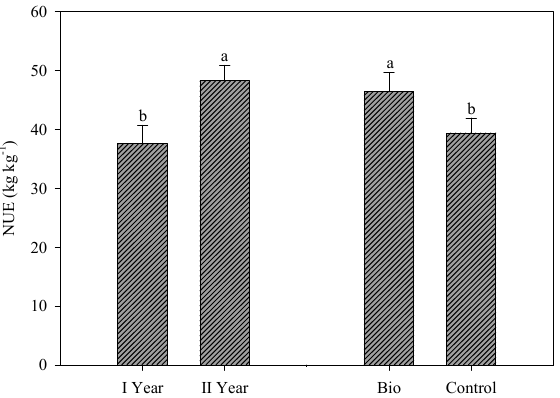
Figure 6. Nitrogen use efficiency (NUE) of barley as affected by growing season (2018–2019 = I Year; 2019–2020 = II Year), biostimulant (treated with biostimulant = Bio and not treated = Control). Different letters indicate significant differences according to Duncan’s test ( p < 0.05).